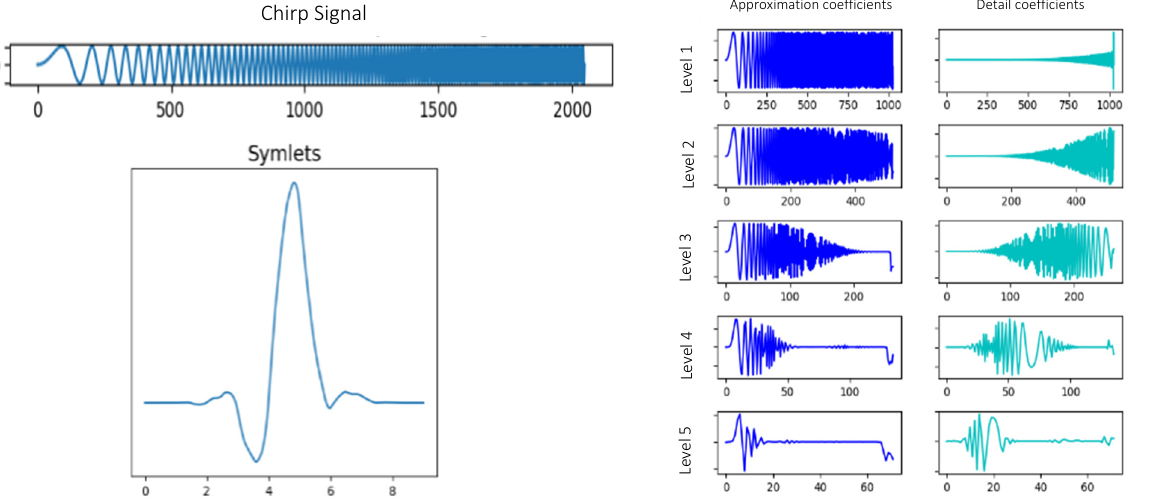
Figure 8. Coefficients of approximation and detail obtained by means of the WT of the signal displayed with a Symlets wavelet.